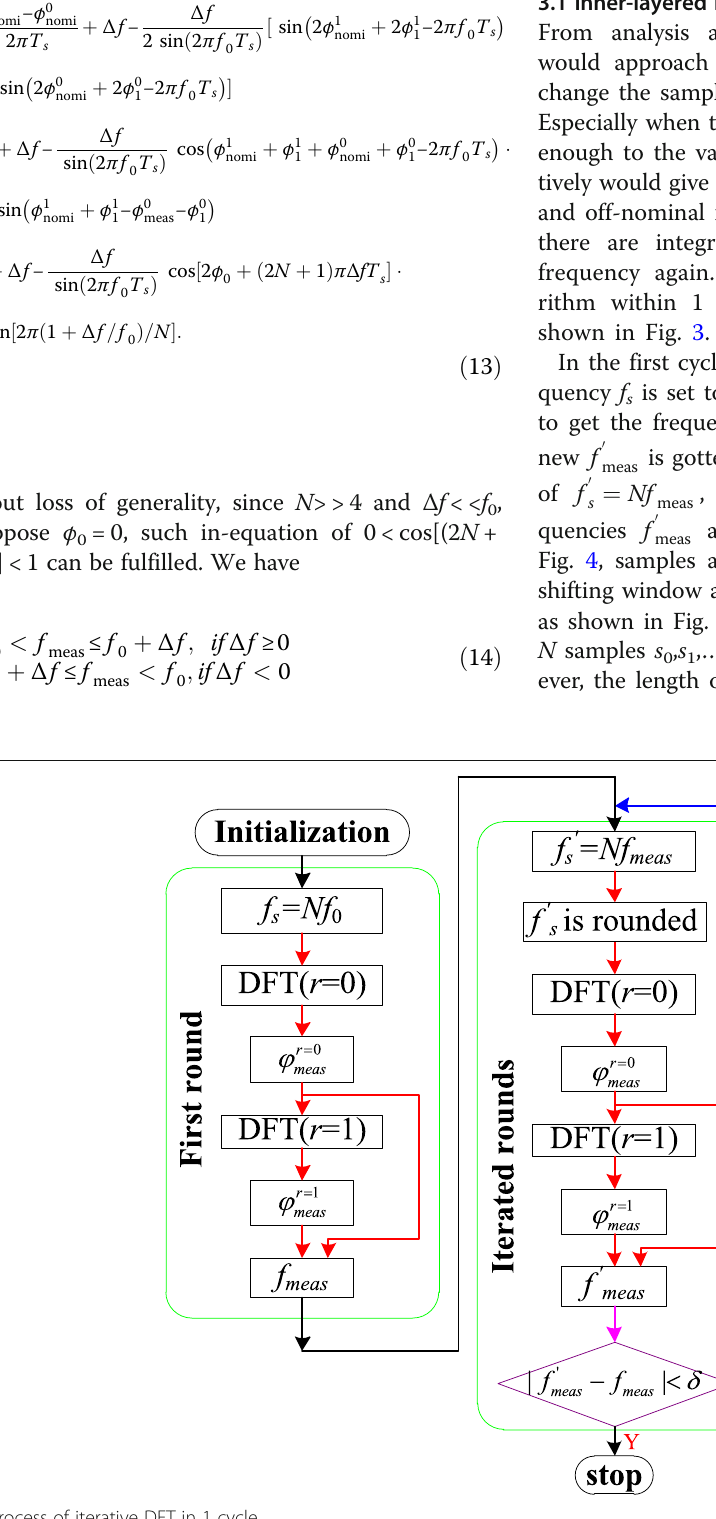
Fig. 3 Process of iterative DFT in 1